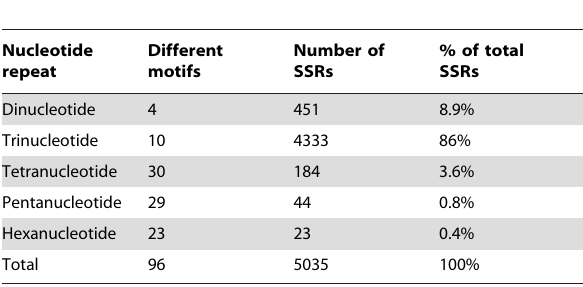
Table 6. Summary of putative SSRs found in P. maximum unigenes.